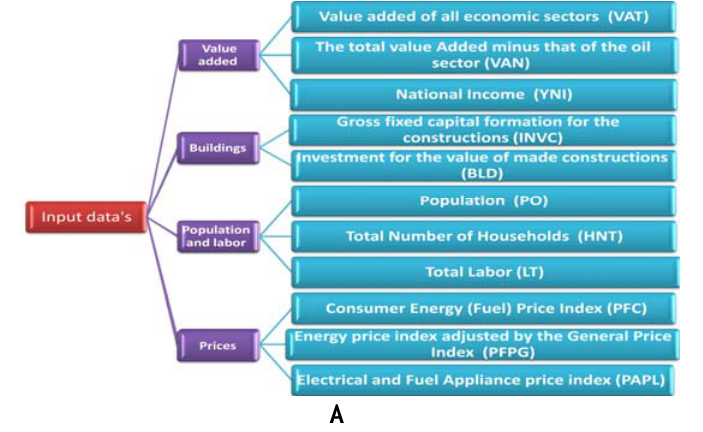
Fig. 2. The prototype of